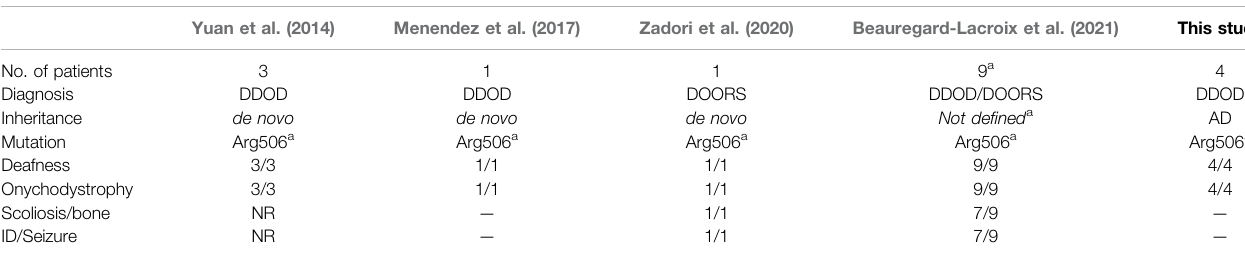
TABLE 1 | Comparison of patients with DDOD/DOORS due to c.1516C > T variant in ATP6V1B2 . Yuan et al.